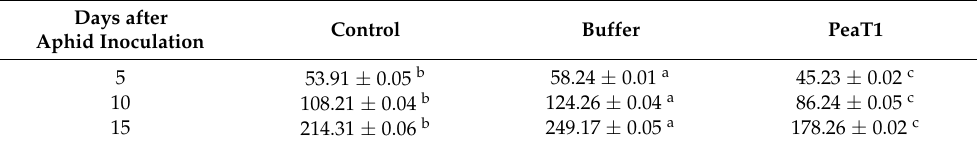
Table 1. M. persicae population variations were seen in PeaT1-, control-, and buffer-treated chili seedlings. To compare data, one-way analysis of variance (ANOVA), Levene’s test with SPSS 18.0, and the least significant difference (LSD) were employed. After aphid inoculation on the same day, significant variations in the letters in the rows can be noticed in all treated samples ( p = 0.05).